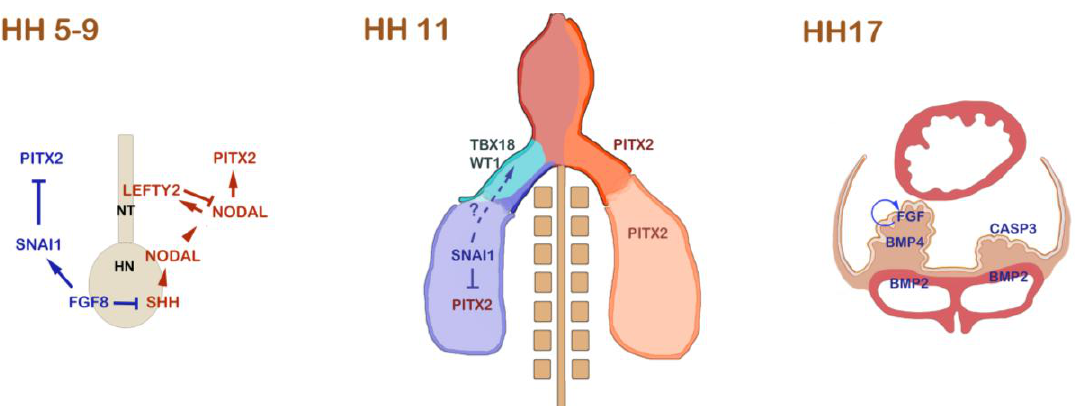
Figure 1. Left-right asymmetric signalling events that are involved in proepicardium (PE) formation in the chick. During gastrulation and the onset of neurulation from HH stage 5 to 9, the NODAL / PITX2 pathway is induced by asymmetric SHH signalling (cid:68)(cid:87)(cid:3) (cid:43)(cid:72)(cid:81)(cid:86)(cid:72)(cid:81)(cid:182)(cid:86)(cid:3) node (HN). SHH induces NODAL at the left side of the node. NODAL induces itself in the left lateral plate mesoderm, where it induces PITX2 . In order to prevent Nodal from spreading to the right side, NODAL induces a feedback inhibitor, LEFTY2 , in the developing notochord (NT). On the right side of the node, FGF8 antagonizes SHH and induces SNAI1 in the right lateral plate mesoderm. SNAI1 acts as a transcriptional repressor of PITX2 on the right side. At HH stage 11, the embryonic heart is depicted. On the left side of the embryo, including the left inflow tract, PITX2 is expressed. In the right lateral plate mesoderm, SNAI1 still lingers and is subsequently downregulated. At this stage, the first PE marker gene expression can be detected. TBX18 is initially expressed on the right side, and the right-sided expression of WT1 follows shortly thereafter [23]. It has been shown that manipulation of FGF8/SNAI1 interferes with asymmetric expression